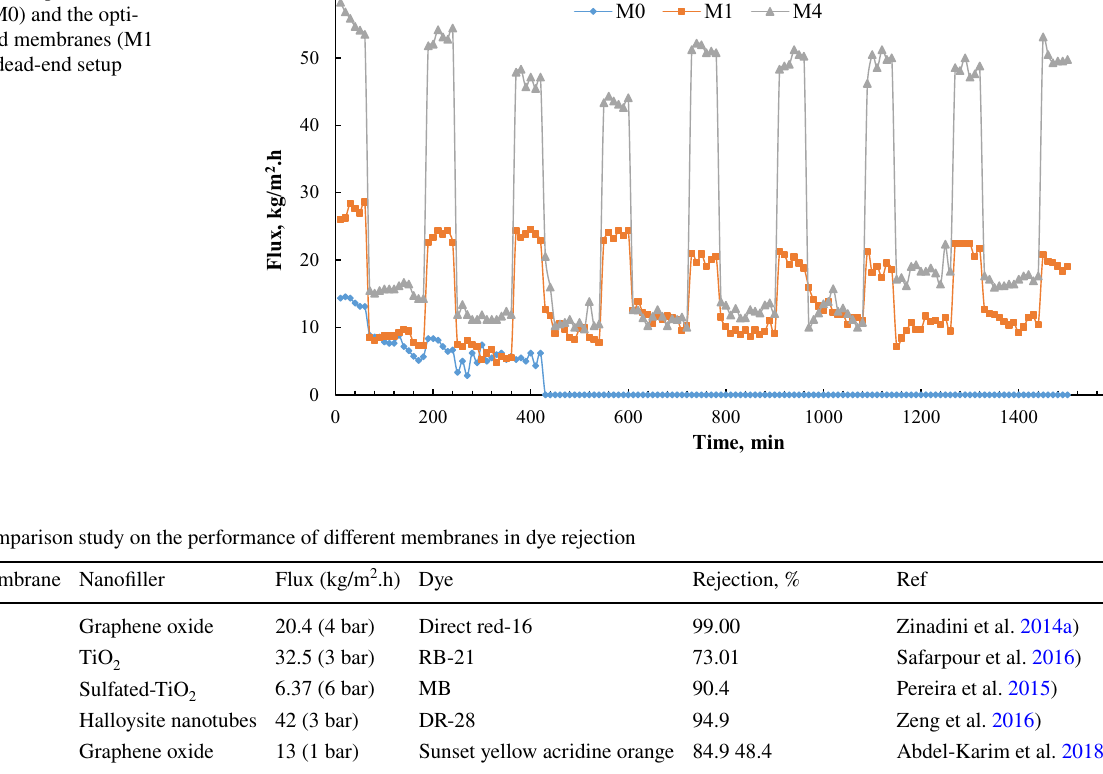
Fig. 13 Long-term performance for the bare (M0) and the opti- mally modified membranes (M1 and M4) in a dead-end setup